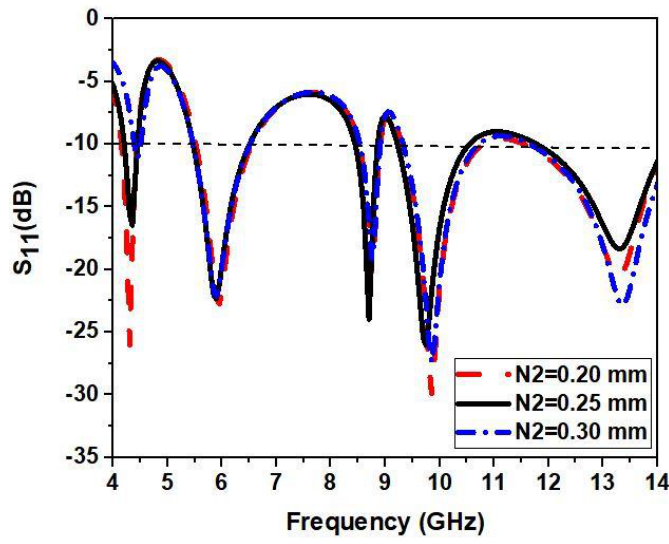
Figure 17. Parametric analysis for variation in N2 for S 11.